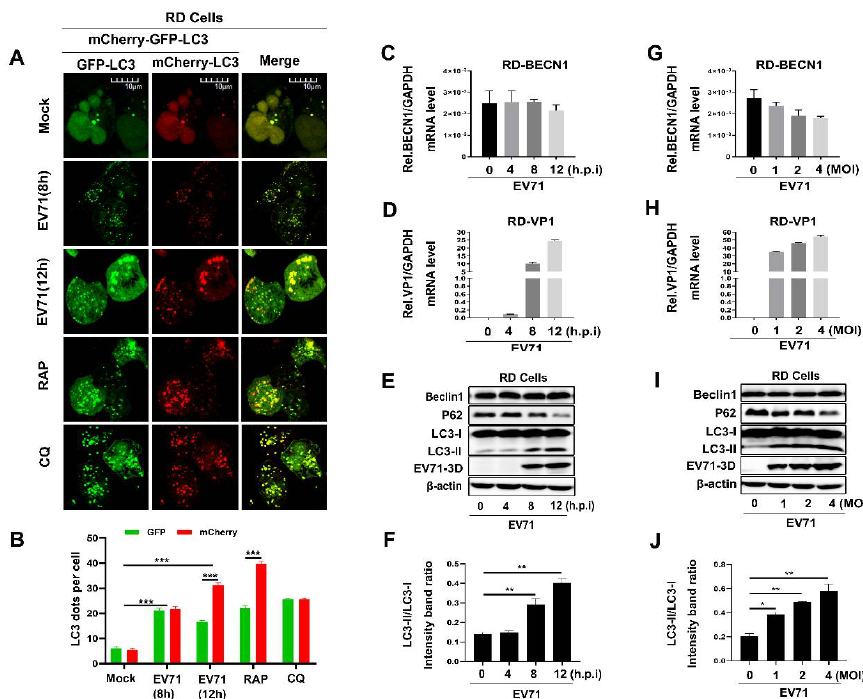
Figure 1. The expression level of Beclin1 was stably maintained during Enterovirus 71 (EV71) infection in rhabdomyosarcoma (RD) cells. ( A , B ) RD cells were transfected with GFP-mCherry-LC3 for 24 h, and then infected with EV71 for different times, or treated with Rapamycin (RAP) and Chloroquine diphosphate (CQ) as the complete and incomplete autophagy flux control, respectively. The images were visualized under Laser scanning confocal microscope. Bar = 10 μm (A), The graph shows the quantification of autophagosomes by taking the average number of dots in 50 cells(B). ( C – F ) RD cells were infected with EV71 (MOI = 1) for indicated time, the relative RNA levels of BECN1 (C) and EV71-VP1 (D) were determined by Real-time PCR, and the relative protein levels of Beclin1 and EV71 3D were detected by Western blot (E), and the LC3-II/LC3-I ratio was measured (F). ( G – J ) RD cells were infected with EV71 for 12 h at an indicated multiplicity of infection (MOI) (0, 1, 2, and 4), the relative RNA levels of BECN1 (G) and EV71 VP1 (H) were determined by Real-time PCR, the relative protein levels of Beclin1 and EV71-3D were detected by Western blot( I ), and the LC3-II / LC3-I ratio was measured ( J ). Graph expressed as mean ± SD, ns, not-significant; * p < 0.05; ** p < 0.01; *** p <